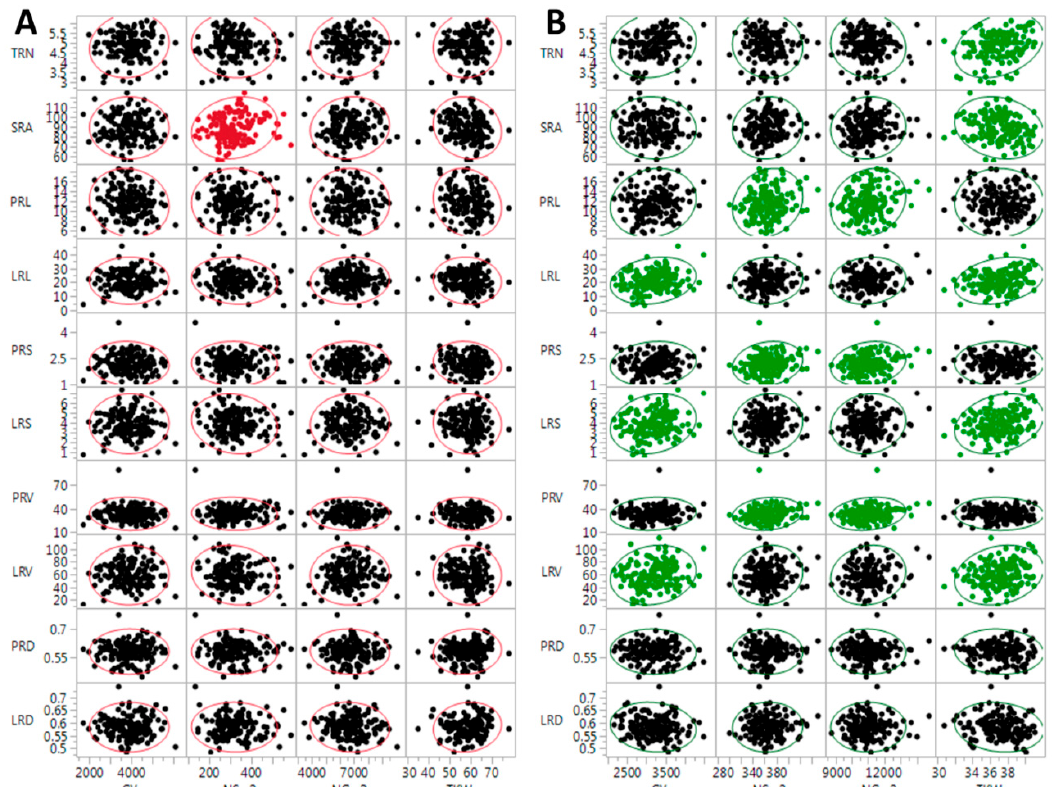
Figure 2. Correlations between seminal root system architecture traits and yield-related traits determined in field experiments receiving high (density ellipse in red, Figure 2 A ) and low (density ellipse in green, Figure 2 B ) water input from sowing to physiological maturity. Significant correlation coefficients ( p < 0.05) are indicated with red and green points. TRN, total root number. SRA, seminal root angle. PRL, primary root length. LRL, total lateral root length. PRS, primary root surface. LRS, total lateral root surface. PRV, primary root volume. LRV, total lateral root volume. PRD, primary root diameter. LRD, mean lateral root diameter. GY, grain yield. NSm 2 , number of spikes per square meter. NGm 2 , number of grains per square meter. TKW, thousand kernel weight.